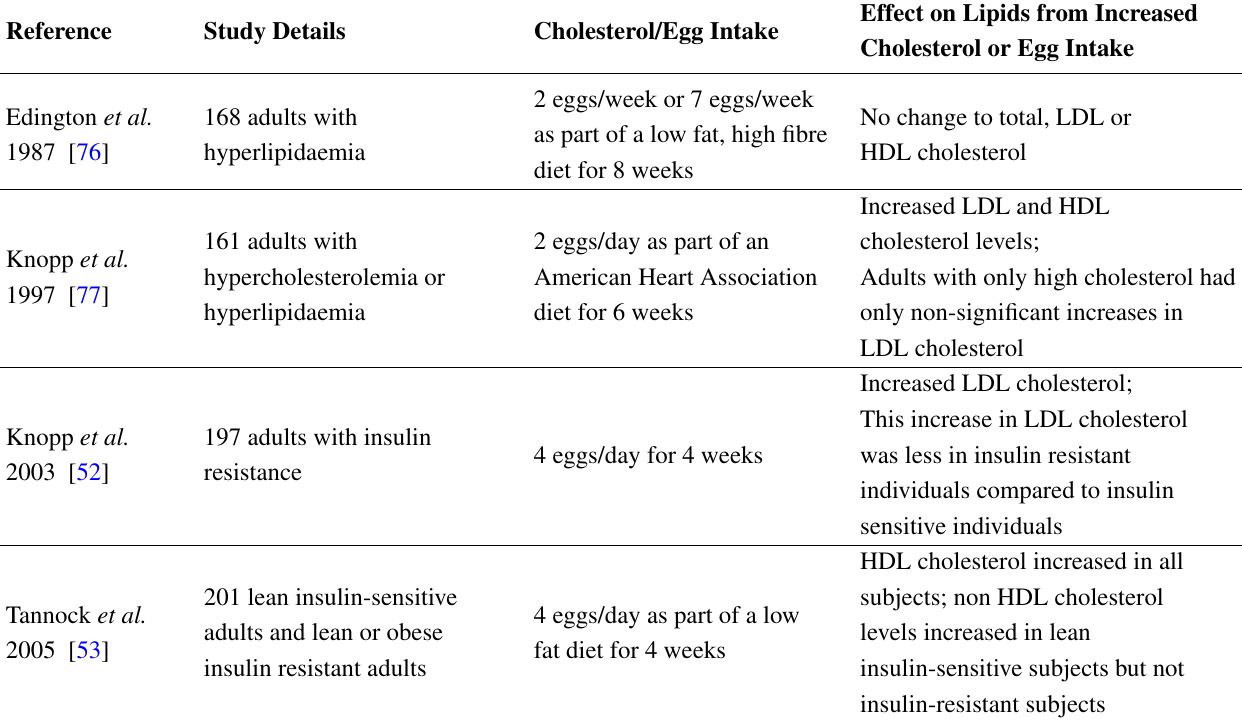
Table 3. Effect of egg consumption on cholesterol levels in those with cardio-metabolic disease, including type 2 diabetes